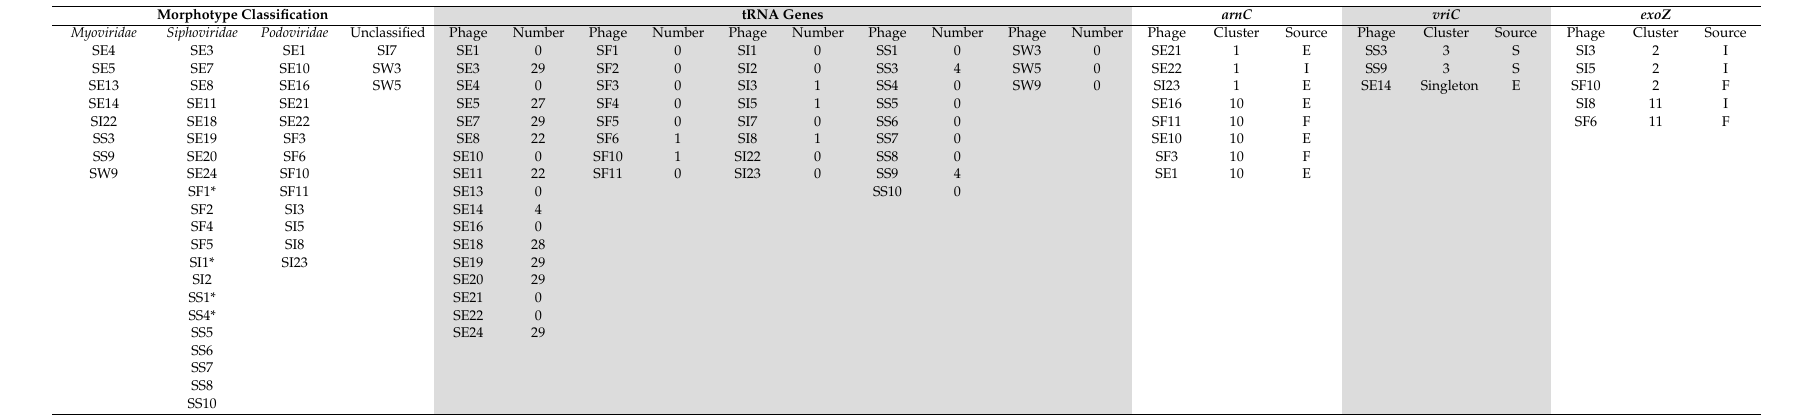
Table 2. Genotypes and taxonomic assignments predicted from in silico analysis of 45 Salmonella phage genomes. Asterisks indicate morphotypes which have been confirmed by transmission electron microscopy [21]. Sources of phages are denoted as follows: sediment (S), cattle feces (F), sewage e ffl uent (E), irrigation water (I), and water tanks from an aquaculture facility